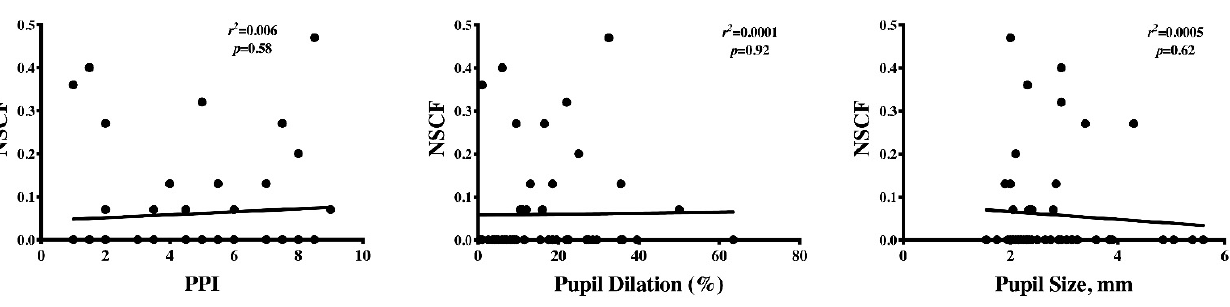
Table 4. Proportion of patients with adequate or inadequate pain control according to changes in the pupillary pain index (PPI) or to the number of skin conductance fluctuations per second (NSCF). Total of patients = 51.